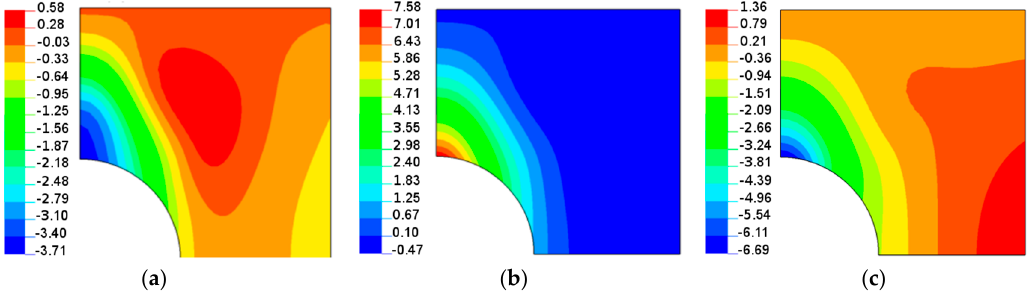
Figure 11. Buckling modes (normal deflections) for the square plate with the circular hole 2 b / L x = 0.4: ( a ) isotropy E 1 / E 2 = 1; ( b ) E 1 / E 2 = 2 θ = 14°; ( c ) E 1 / E 2 = 2 θ = 60°.